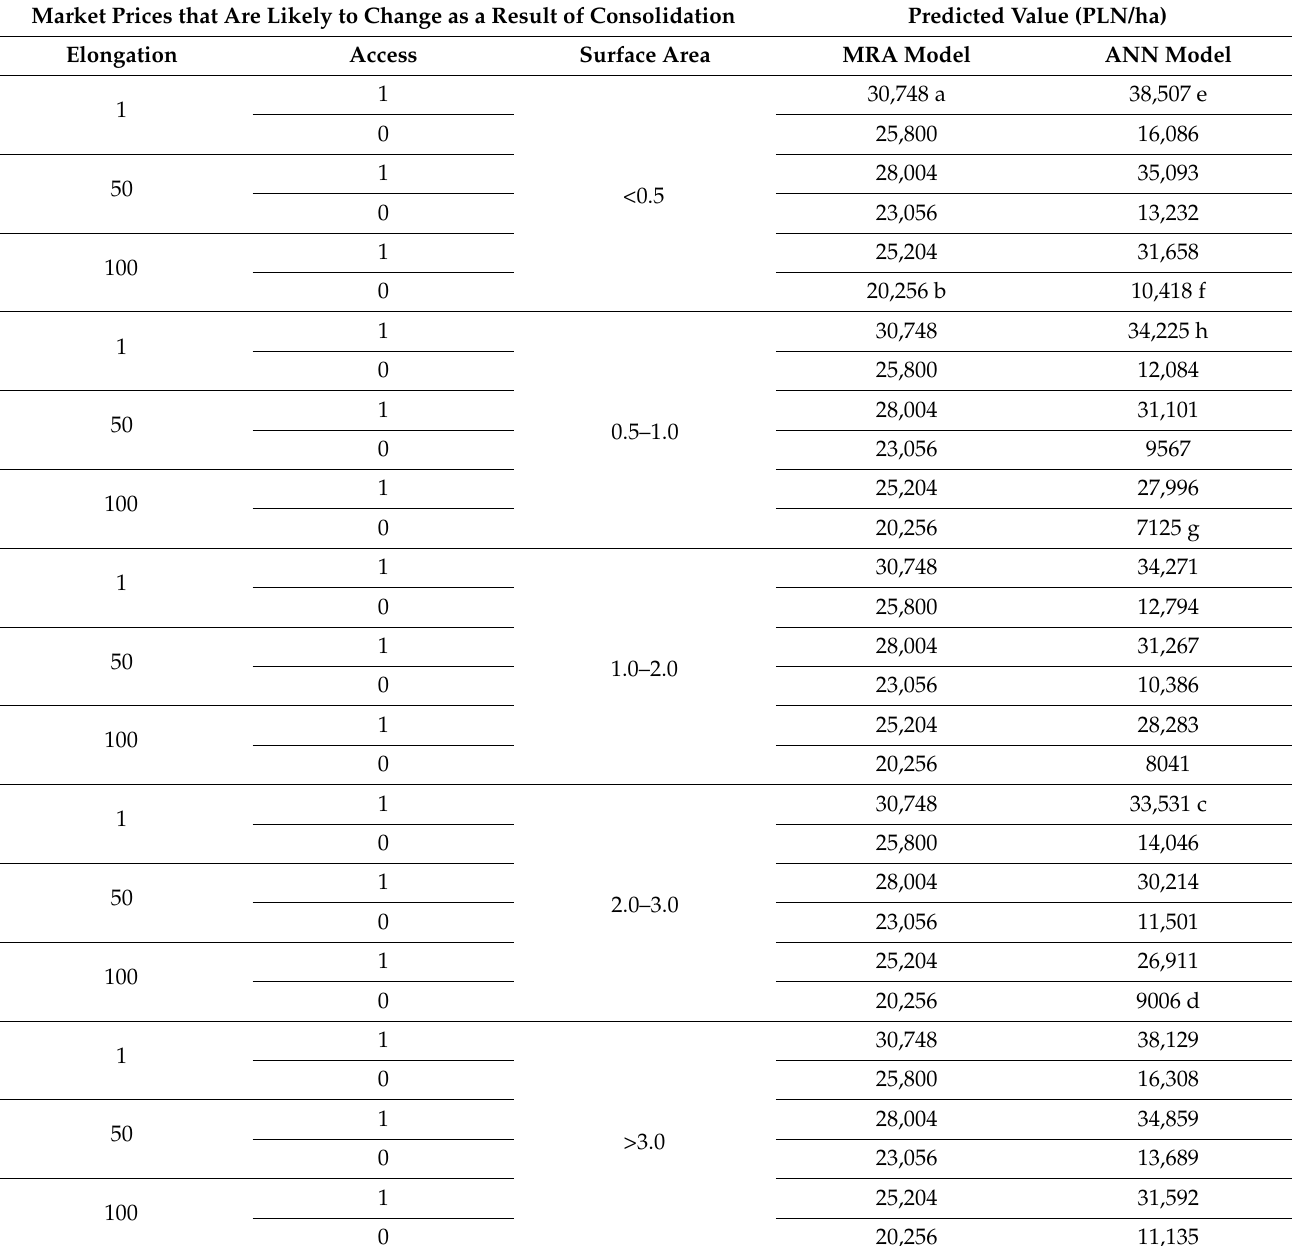
Table 4. Predicted changes in land value as a result of changes in selected features of